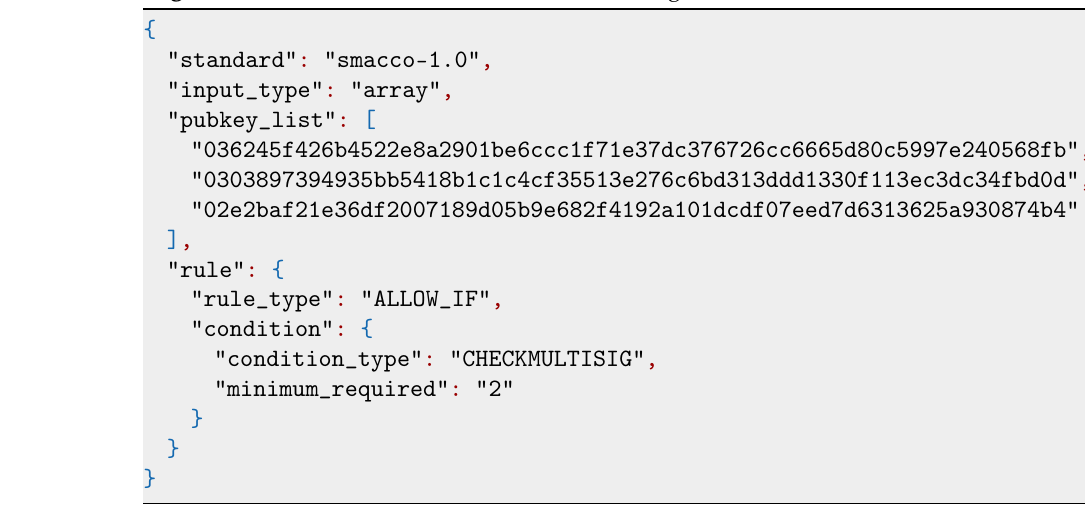
Algorithm 3 Code in JSON format for a multi signature account.